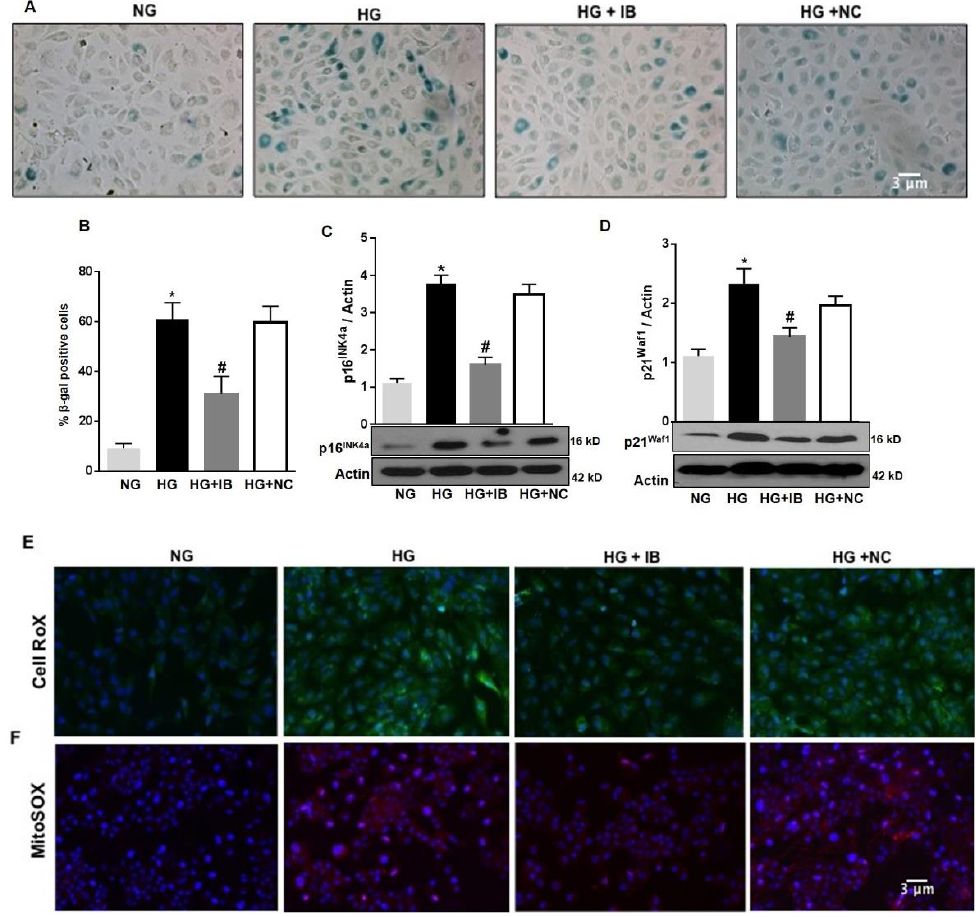
Figure 4. MiR-34a inhibition prevents high glucose-induced vascular senescence and oxidative stress in HuREC. HuREC were transfected with 50 nM of miR-34a inhibitor (miR-34a IB) or negative control (NC) for 24 h and exposed to HG (25 mM D -glucose) or NG (5 mM D -glucose) or the osmotic control LG (25 mM L -glucose) for 72 h. ( A ) Micro images showing SA- β -Gal staining (blue cells) in